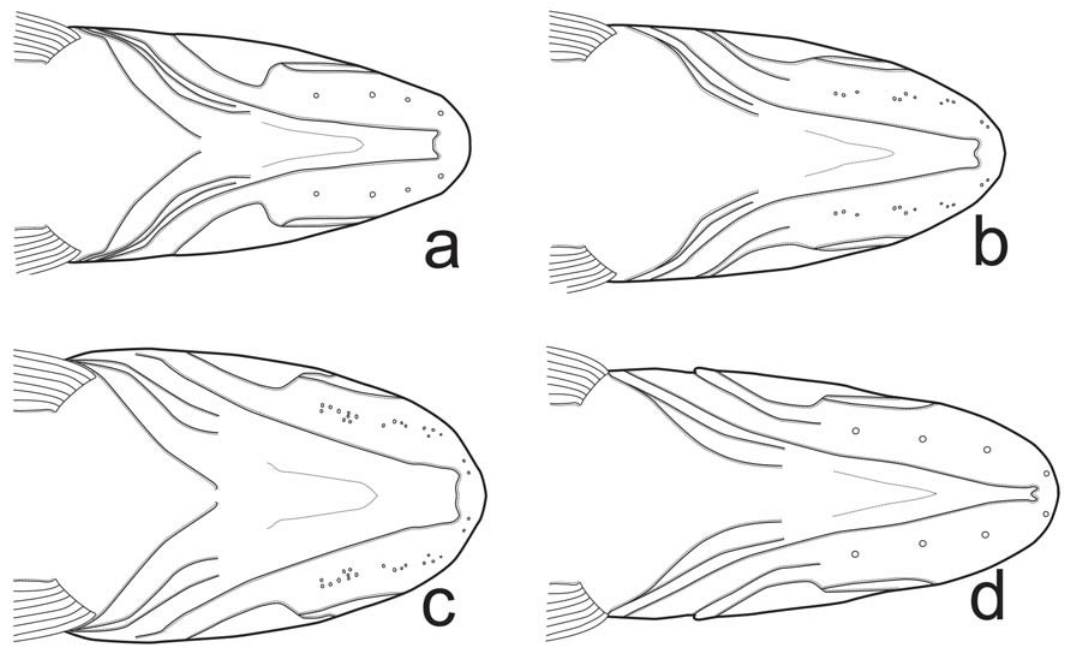
Fig. 1. Ventral view of head of (a) Hoplias curupira , MZUSP 24403, 55.5 mm SL; (b) H . curupira , MZUSP 24403, 92.2 mm SL; (c) H . curupira , MZUSP 24403, 162.2 mm SL and (d) H . malabaricus , MZUSP 90416, 101.7 mm